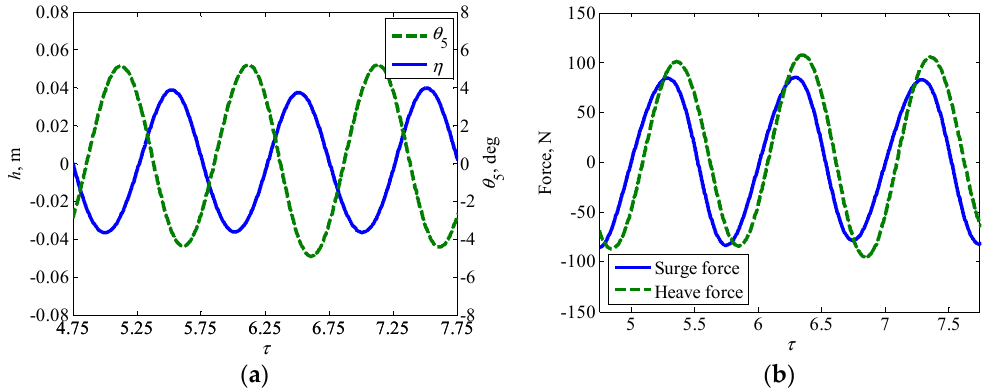
Figure 6. Measured free surface elevation at the Duck position with the Duck be removed from the NWT and hydrodynamic responses of the Duck at T = 1.6 s and H = 0.075 m: ( a ) measured free surface elevation and pitch angular displacement of the Duck; ( b ) surge and heave hydrodynamic forces applied on the Duck.